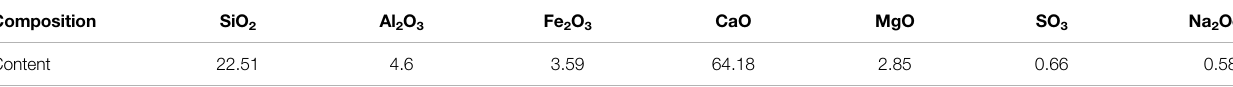
TABLE 1 | Cement chemical components (%).